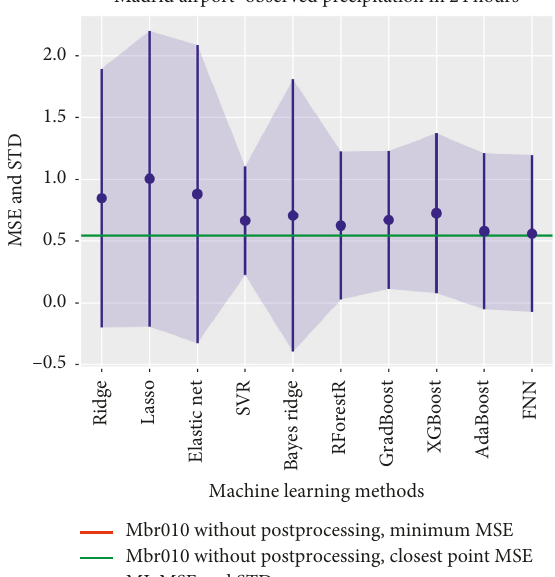
Figure 23: Precipitation in 24 hours, standardized calibration plot for Madrid airport. Horizontal axis as in Figure